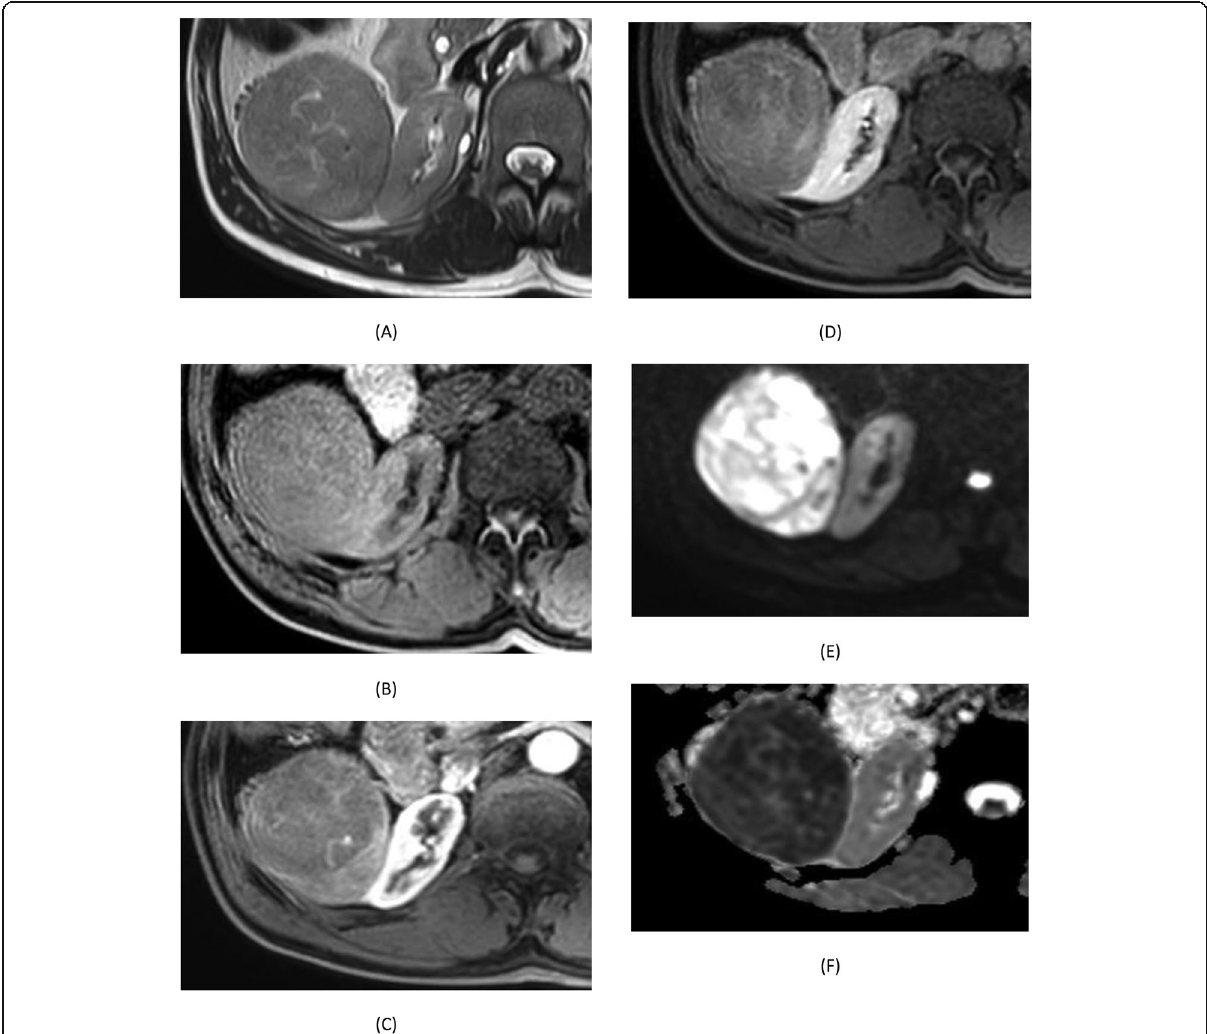
Fig. 6 Multiparametric MRI of cb-RCC. A case of cbRCC in the right kidney of a 60-year-old male. a Axial T2-W fast SE MR image shows the pronounced renal mass slightly lower SI compared with renal parenchyma. A ROI has been drawn and then reported on all sequences. Axial non- enhanced ( b ) and gadolinium-enhanced T1-W spoiled GRE-MR images in corticomedullary ( c ) and nephrographic ( d ) show early and moderate heterogeneous enhancement of the mass in corticomedullary and nephrographic phases. Axial DWI (b800mm 2 /s) ( e ) and ADC maps ( f ) show restriction of diffusion into the renal mass with ADC value (1.1 × 10 − 3 mm 2